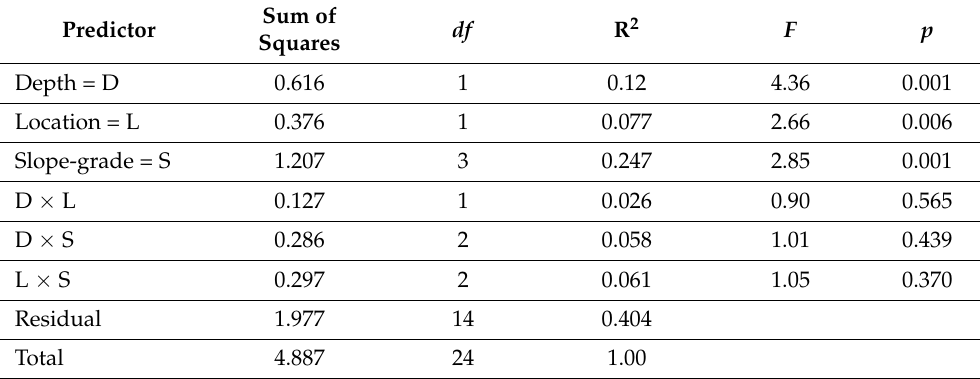
Table 1. PERMANOVA based on the Jaccard measures of similarity performed on species/samplematrix. Sum of df R Predictor Squares